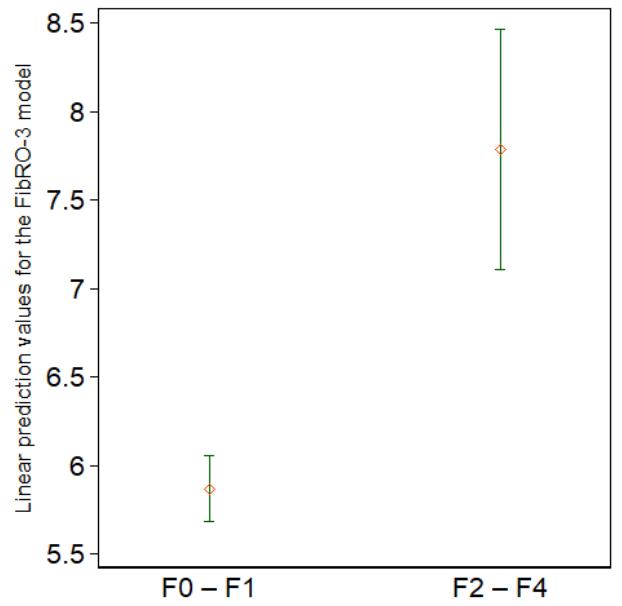
Figure 5. Summary statistics for the linear prediction values according to the presence of significant fibrosis (F0–F1 vs. F2–F4). The diamonds represent the means, whereas the upper and lower short horizontal lines represent the upper and lower ends of the 95% confidence intervals, respectively ( n = 167).